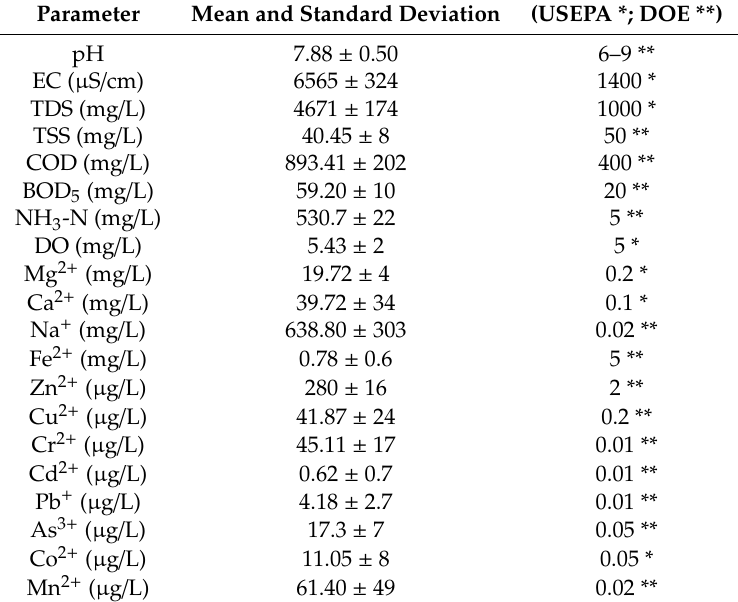
Table 1. Physico-chemical characteristics and heavy metals of leachate.